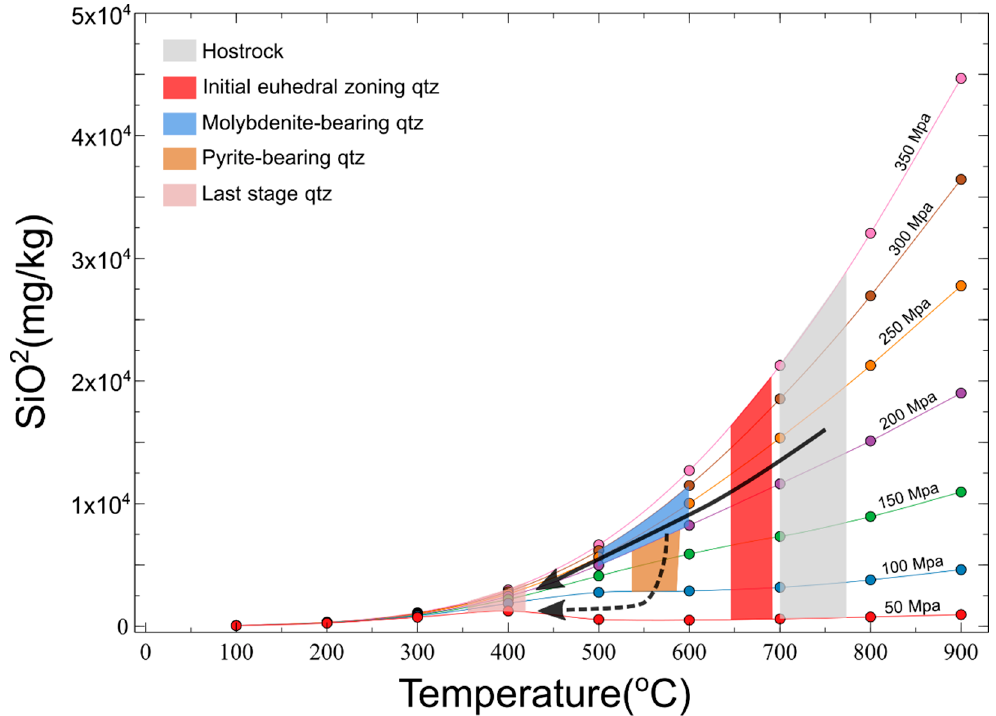
Figure 12. Evolution of supercritical fluid based on inferred pressures and temperatures (solid and dashed arrow are the inferred P-T path) and the model of quartz solubility in H 2 O [40]. Two possible scenarios are presented here. The solid arrow represents the magmatic fluid upon gradual cooling that precipitated various quartz vein stages. The dashed arrow depicts a second scenario, where the decompression of the initial fluid takes place and induces the precipitation of mineralization-bearing quartz. Both mechanisms will tend to decrease at lower temperatures and precipitate the last stage of the qtz vein.